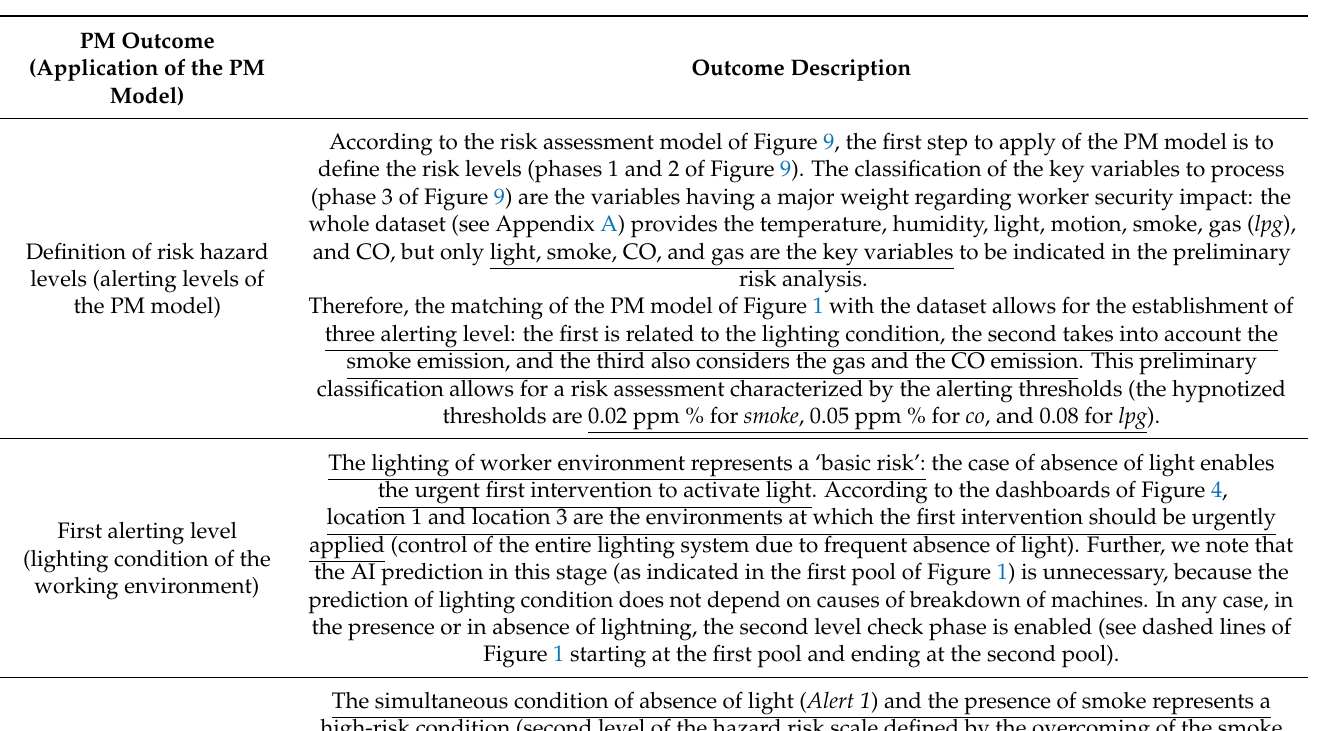
Table 6. PM outcomes of the